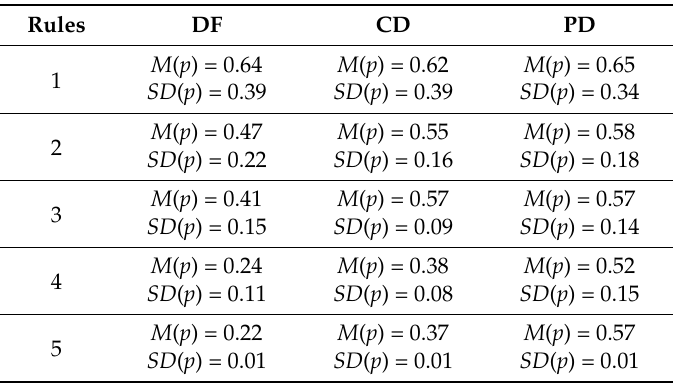
Table 4. Item difficulty split by the number of